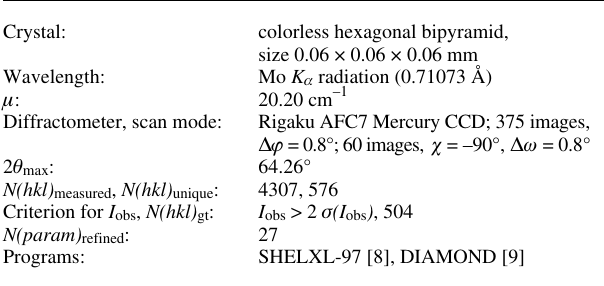
Table 1. Data collection and